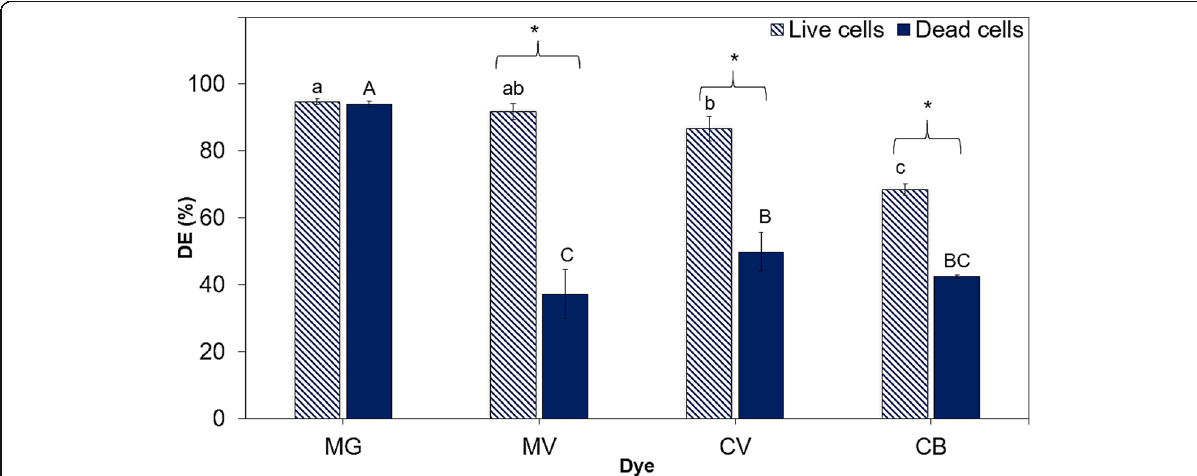
Fig. 9 Comparison of maximum DE by live and dead cells on TPM dyes at combined optimized conditions. Means with the same small letters (live cells) and the same capital letters (dead cells) are not significantly different at HSD ( 0.05 ). Bars indicate ± SEM. ‘ * ’ indicates significant difference based on paired T -test (p < 0.05) between live and dead